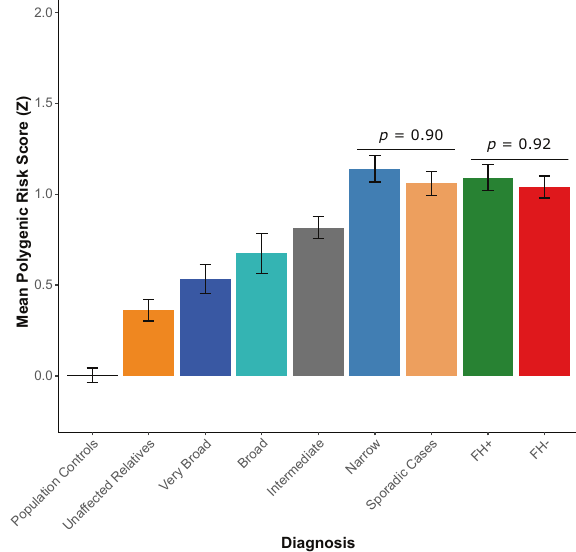
Fig. 1 Mean Leave-N-Out PGC3-SCZ PRS for each of the diagnostic categories in the ISHDSF sample, sporadic SCZ cases and ancestry-matched population controls. A subset of sporadic cases with family history (FH) information are further divided into FH + (green bar) and FH − (red bar) categories. Unaffected relatives (dark orange bar) are distinct from population controls (black bar) as they represent unaffected individuals in the families. Familial SCZ cases are represented in the narrow spectrum category as described in the methods section. Error bars represent the standard error of the observed mean. X axis shows each of the diagnostic categories. Y axis shows the mean normalized Z-score for